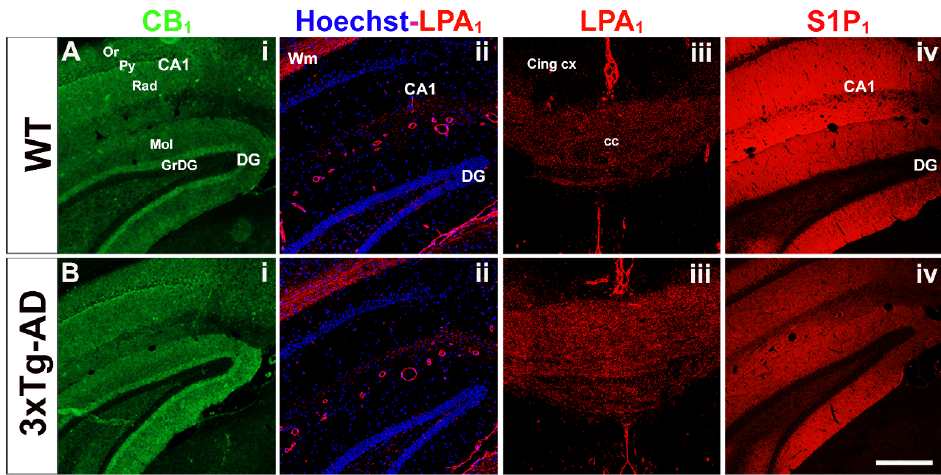
Figure 4. Immunolabeling of CB 1 ( i, green ), LPA 1 ( ii and iii, red ), S1P 1 ( iv, red ) receptors in the hippocampus ( i, ii and iv ) and corpus callosum ( iii ) from WT ( A ) and 3xTg-AD mice ( B ). Note that CB 1 and S1P 1 receptors are distributed in the gray matter, whereas LPA 1 receptors are mainly expressed in white matter regions. The different hippocampal subfields exhibit specific immunostaining patterns. CA1; CA1 region of hippocampus, DG; dentate gyrus of hippocampus, Or; oriens layer of CA1, Py; pyramidal layer of CA1, Rad; radiatum layer of CA1, Mol; molecular layer of DG, GrDG; granular layer of DG, Wm; white matter, cc; corpus callosum, Cing cx; cingular cortex. Scale bar = 200 µm. Some of these three neurolipid receptors have also been localized in astrocytes, mainly the S1P 1 receptor subtype. Therefore, the study of astroglial cells by immunoflu- orescence was performed in those brain regions which showed marked differences in the functional coupling of the analyzed GPCRs. Two different markers, glial fibrillary acidic protein (GFAP) and S100B, were used to identify astrocytes directly in the tissue. The immunosignal observed by using both markers exhibited different immunostaining patterns showing that astrocytes were mainly distributed in the gray matter. GFAP im- munoreactivity clearly delineated the body and the processes of the astrocytes, whereas S100B immunosignal was more restricted and mainly confined to the astrocyte body. The total density of Hoechst-stained nuclei was not modified in transgenic mice. In this sense, both the density of astrocytes and the total area stained with GFAP or S100B were nor- malized as percentages of total nuclei or total Hoechst-stained area, respectively. Marked changes in density, as well as in cell size, were found in hippocampal CA1 and dentate gyrus fields in 3xTg-AD mice, demonstrating not only a decrease in the population of astrocytes, but also their atrophy or shrinkage. These observations allowed us to clearly differentiate between both genotypes depending on the astroglial-associated im- munosignal. However, those differences were not statistically significant in other brain regions such as the granular olfactory bulb (Figure 5).